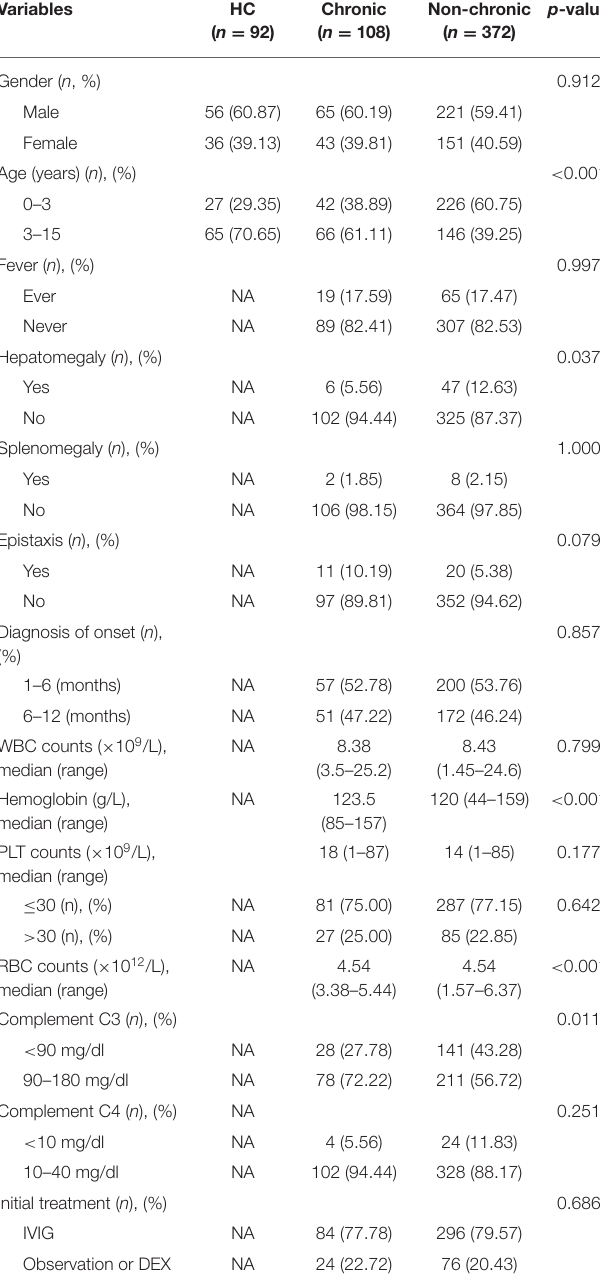
TABLE 1 | Clinical characteristics of the pediatric ITP patients. TABLE 2 | Differences in herpes virus infection between chronic and non-chronic pediatric ITP